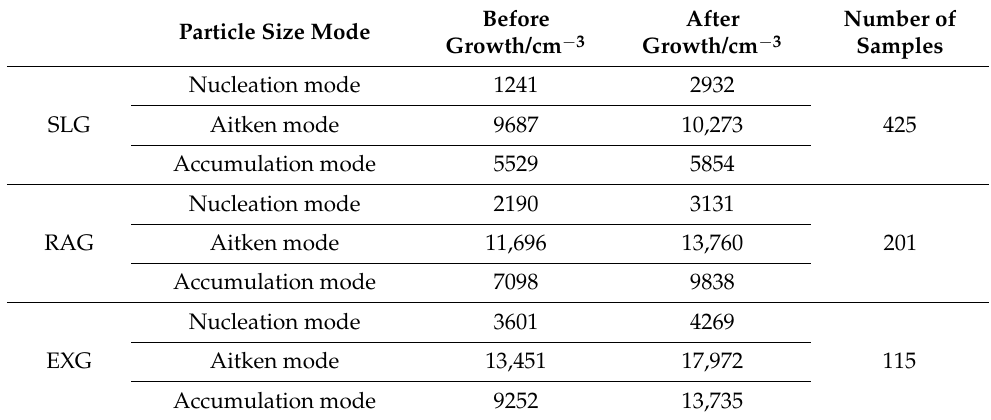
Figure 6. Average size distribution of aerosol particle before and after slow growth (SLG), rapid growth (RAG), explosive growth (EXG), and all growth period (GP) in Beijing. Table 1. Statistical values of particle number concentration in each mode before and after (1-h interval) slow, rapid, and explosive growth in